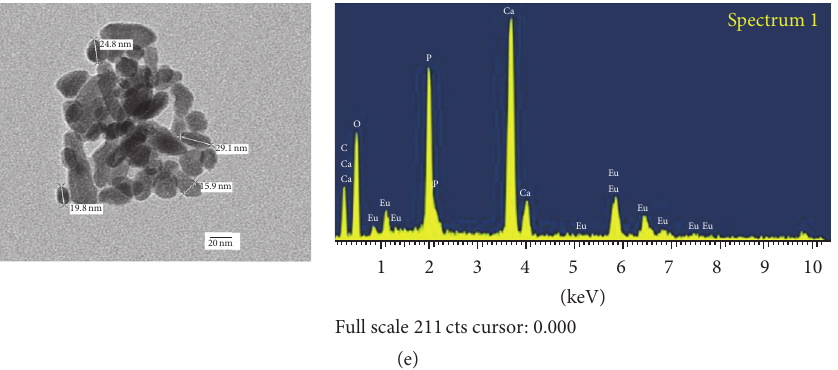
Figure 2: TEM and EDS spectroscopy. (a) Pure HAP, (b) HAPEu3%, (c) HAPeu5%, (d) HAPEu10%, and (e) HAPEu20%. Sizes are estimated to be around 10–50nm.